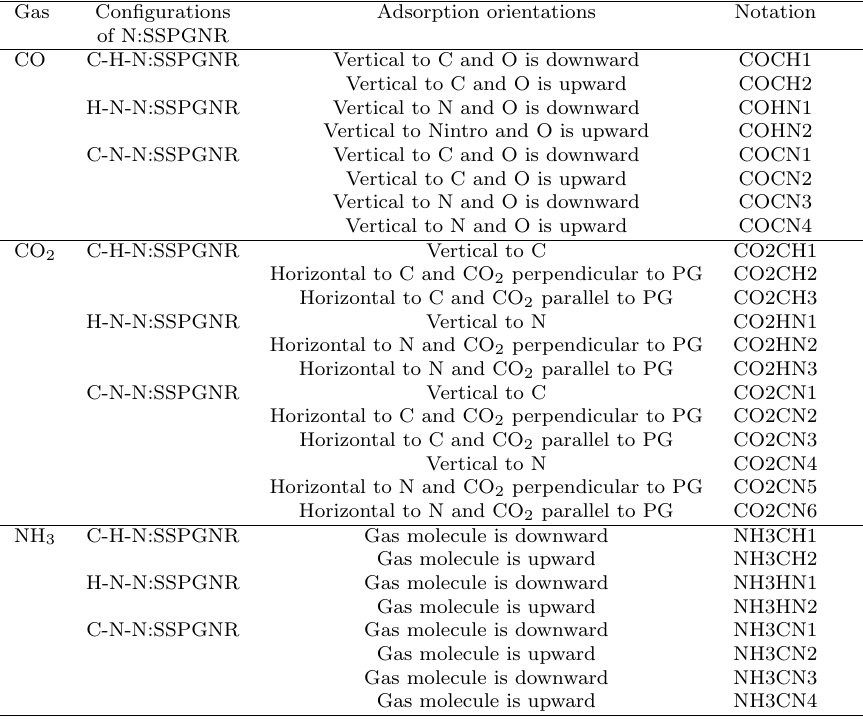
Table 1: Adsorption orientations and corresponding numbers for the adsorption structures of CO, CO 2 and NH 3 on the edge of